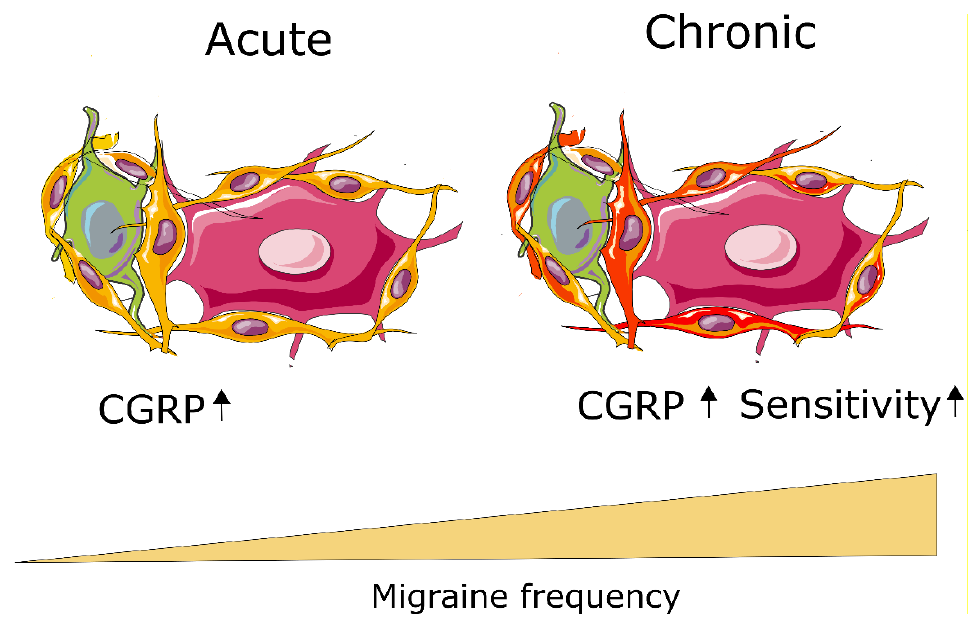
Figure 1. Chronification of migraine. Small CGRP-containing neurons (green), and larger CGRP receptor-containing neurons (pink) are surrounded by satellite glial cells. We postulate that activation of the satellite glial cells (indicated by a change in color from orange to red) sensitizes the glia/neuron subunit, thereby decreasing the migraine threshold and leading to increased migraine frequency.